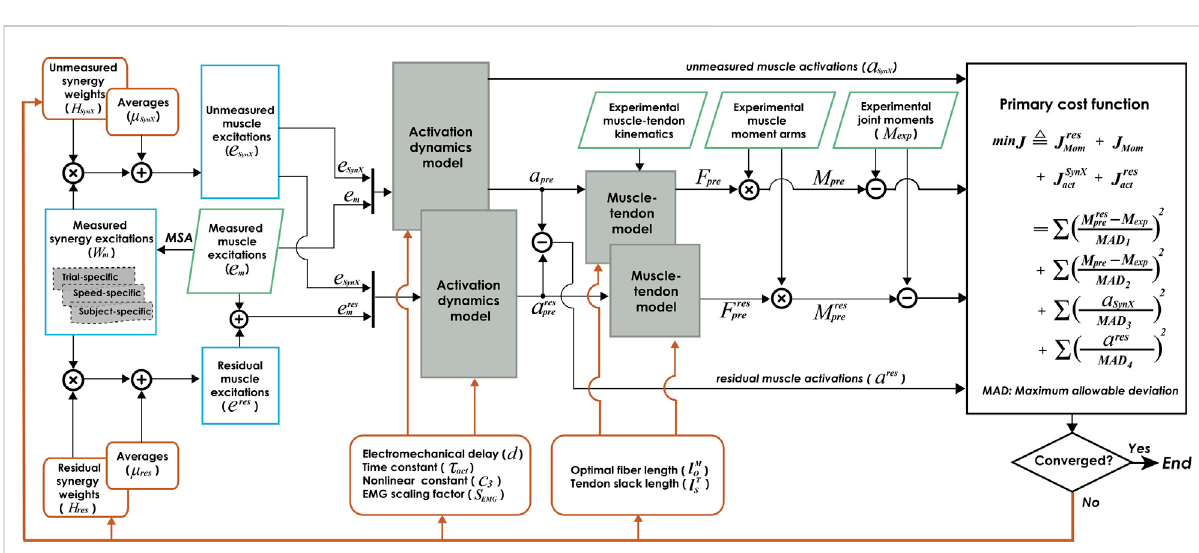
FIGURE 1 Flow chart of EMG-driven model calibration with synergy extrapolation (SynX) to estimating missing EMG signals. Orange rectangle boxes indicate optimization design variables, including activation dynamics model parameters, muscle-tendon model parameters, average values and synergy vector weights for unmeasured muscle excitations, and average values and synergy vector weights for residual excitations. The design variables were calibrated simultaneously by solving a nonlinear multi-objective optimization problem, described as “ Params + SynX + Res ” calibration. The objective function was formulated as a trade-off between joint moment tracking accuracy (with and without residual excitations included) and the magnitude of estimated unmeasured and residual muscle activations. Green parallelogram boxes indicate variables that were measuredexperimentally.Bluerectangle boxesindicate importantintermediatevariables generatedwithintheSynXprocess. MSAstandsfor muscle synergy